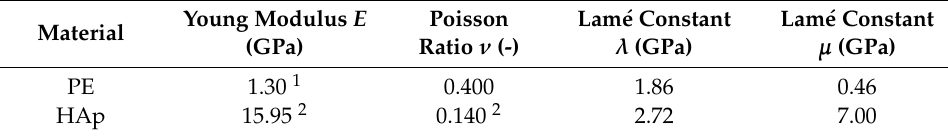
Table 5. Material properties of matrix polyethylene PE and inclusions HAp.